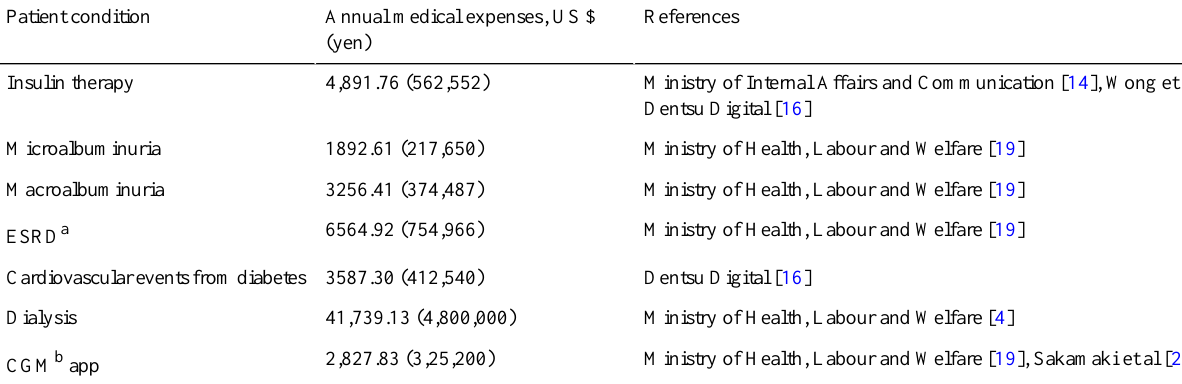
Table 3. Medical fee for each patient